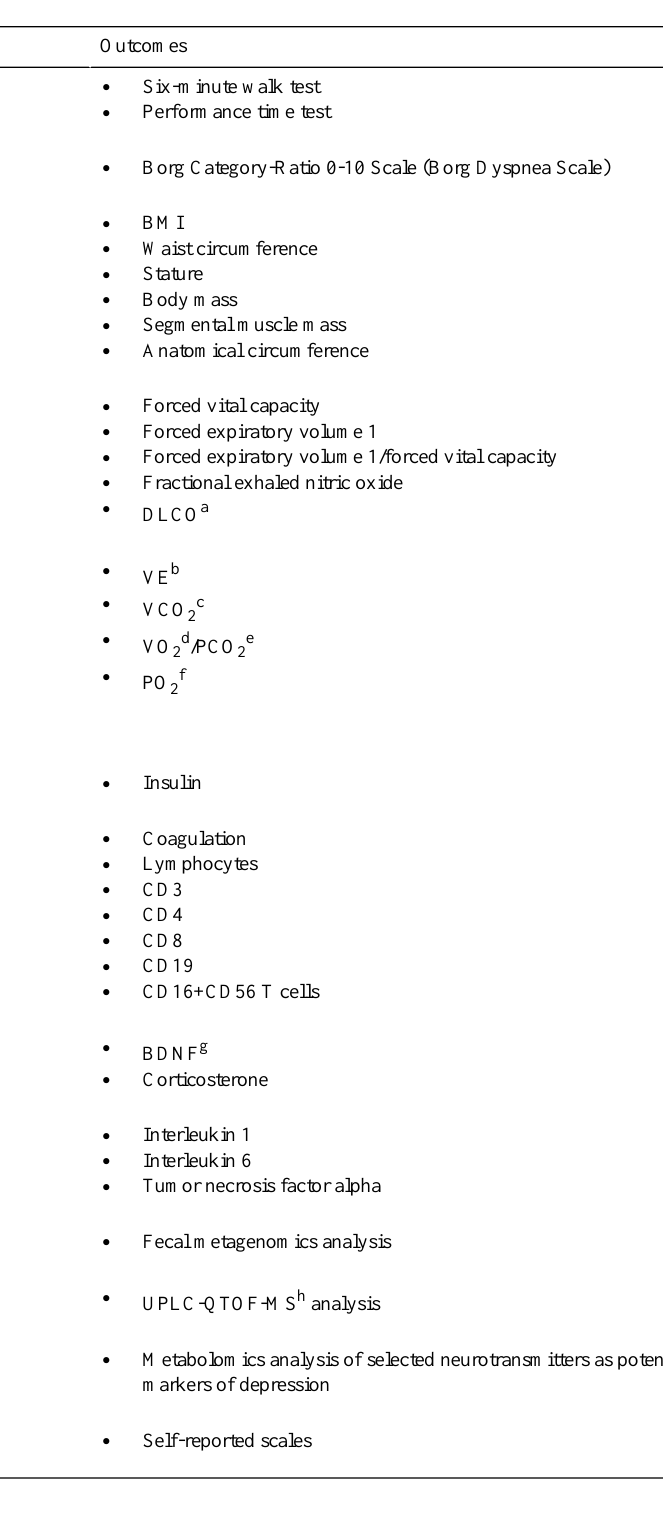
Table 2. Description of the outcome